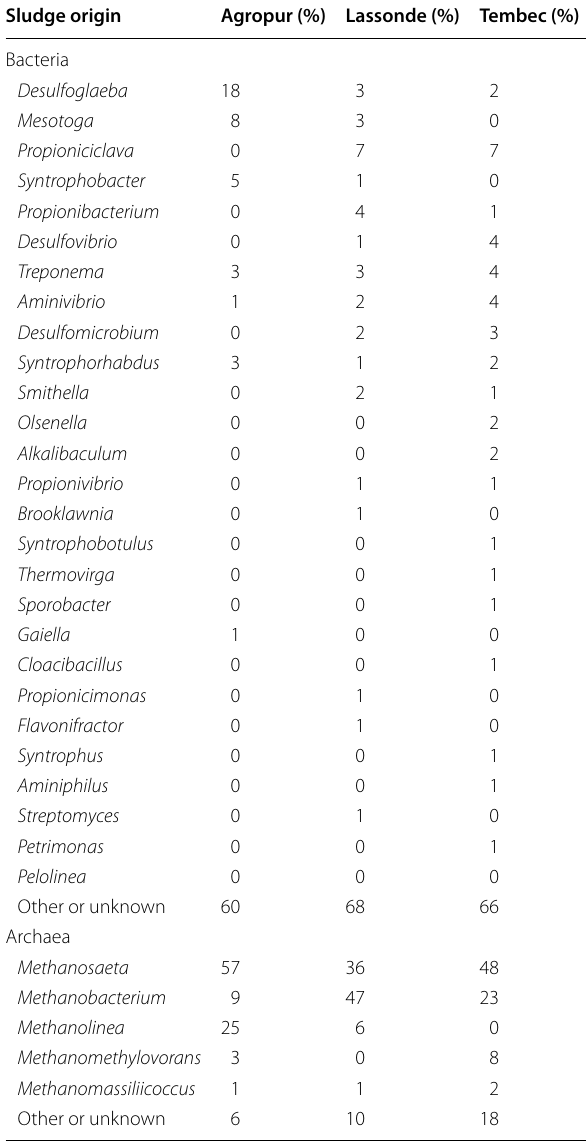
Table 2 Relative abundance of bacterial and archaeal genera for each sludge Sludge origin